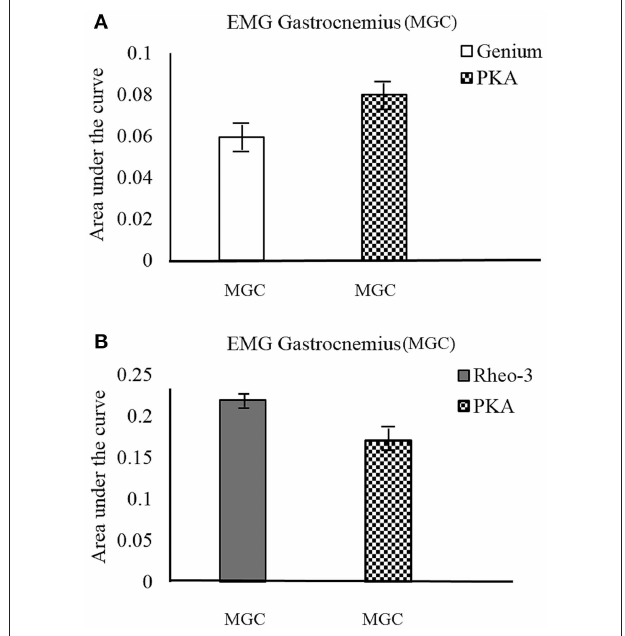
FIGURE 3 | MGC muscle EMG activation profile during outdoor cross walk testing. The EMG activation was indexed as area under the curve (AUC) of the EMG signal. (A) compares the MGC muscle activation on the contralateral side between the MPK-1(Genium) and the PKA device. (B) compares the MGC muscle activation on the contralateral side between the MPK-2(Rheo-3) and the PKA device for CS02.